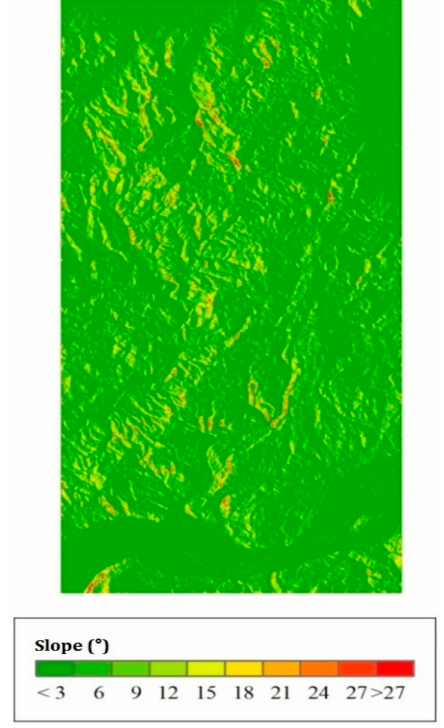
Figure 9. The slope map of the study area in the range direction.